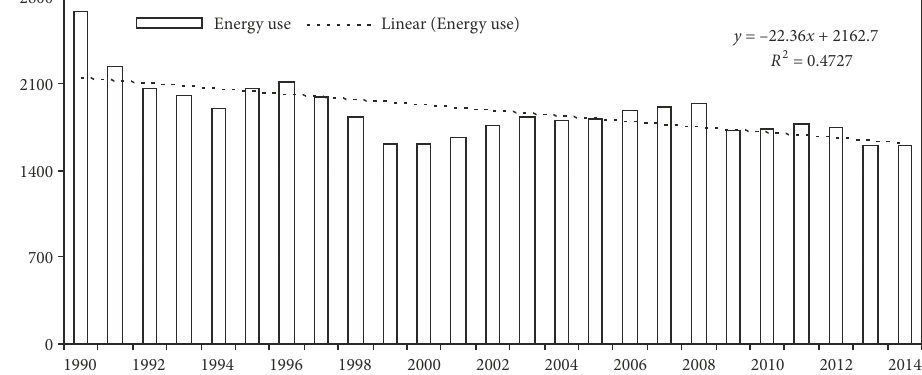
Figure 3. Energy use (kg of oil equivalent per capita Data source: WBD) (source: authors based on World Bank Database, 2018b)